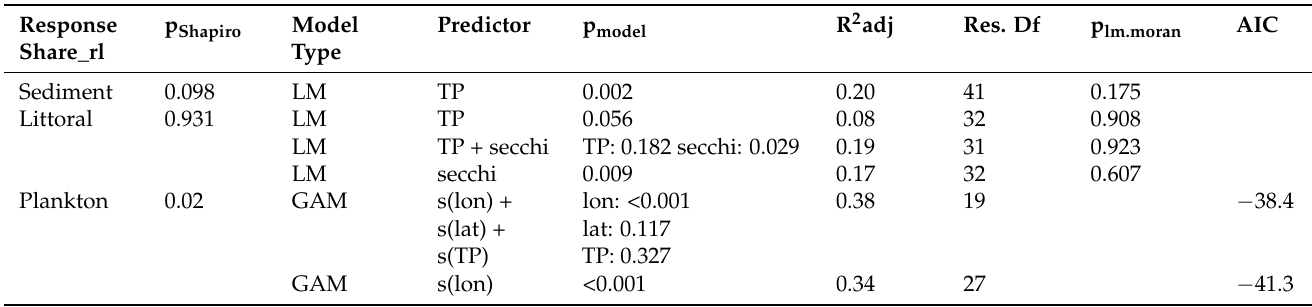
Table 2. A significant correlation was detected based on linear regression models (LMs) between the share of RL species (share_rl) and total phosphorous (TP) and Secchi depth (secchi) for sedimentary and littoral assemblages, respectively. For planktic assemblages, share_rl significantly decreased with longitude (lon) based on GAMs. p -values for the Moran-test of LMs residuals and AIC values are given where relevant. Within GAMs, inclusion of smoothers is indicated by placing the predictor within